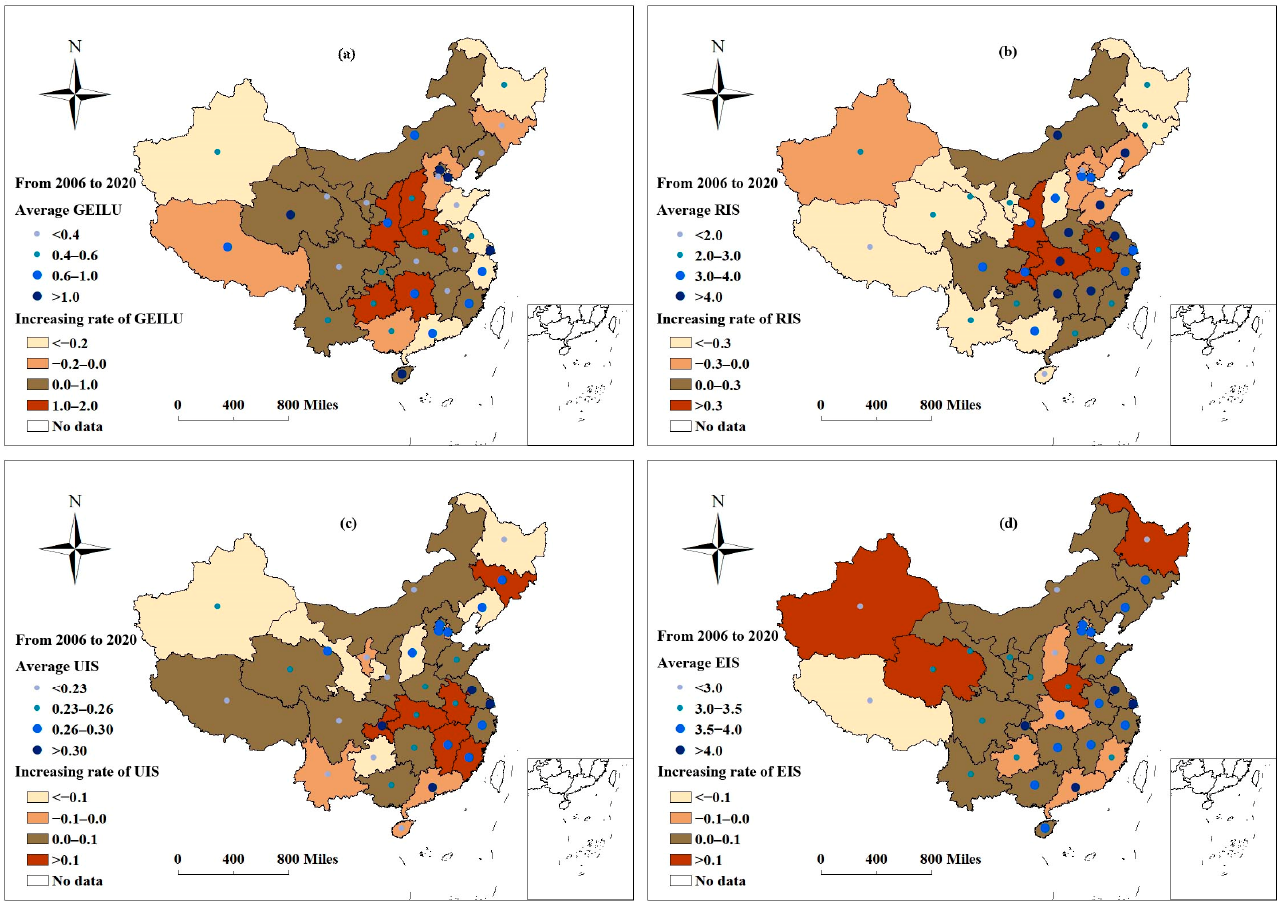
Figure 5. The average GEILU, RIS, UIS, and EIS of research units and the increasing rates from 2006 to 2020. ( a – d ) shows the average GEILU, RIS, UIS, and EIS of each research unit and the increasing rates from 2006 to 2020, respectively.